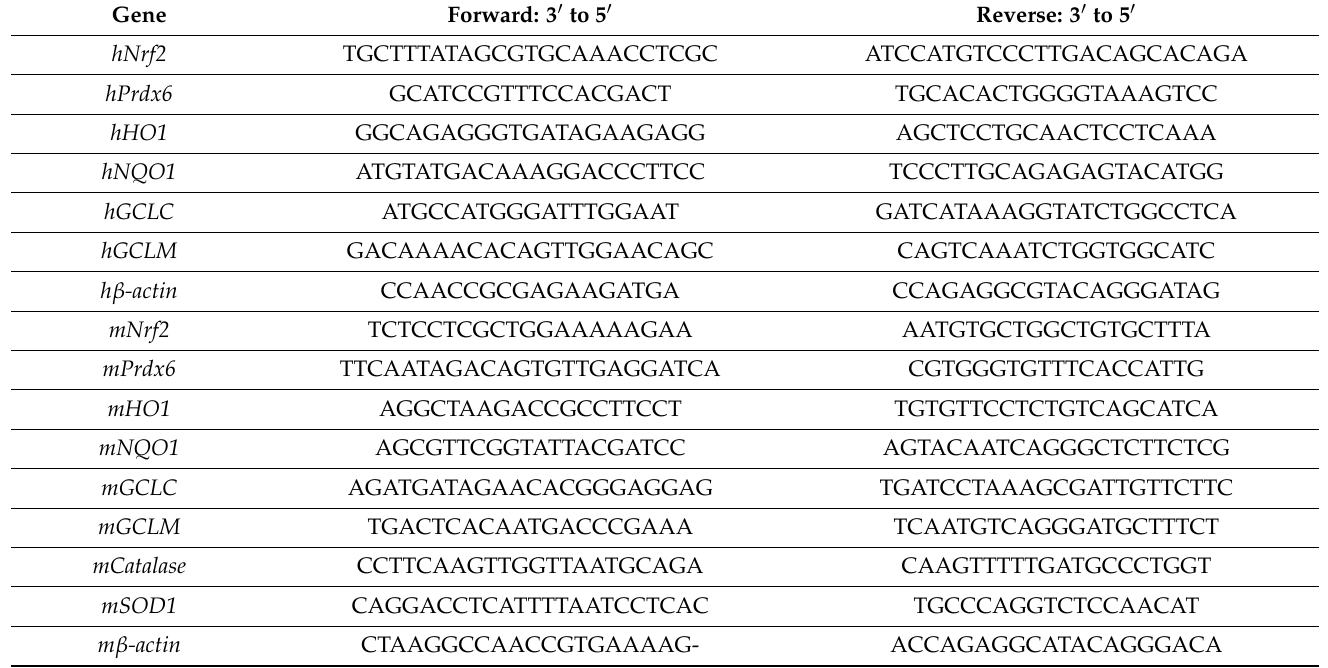
Table 1. RT-qPCR primer